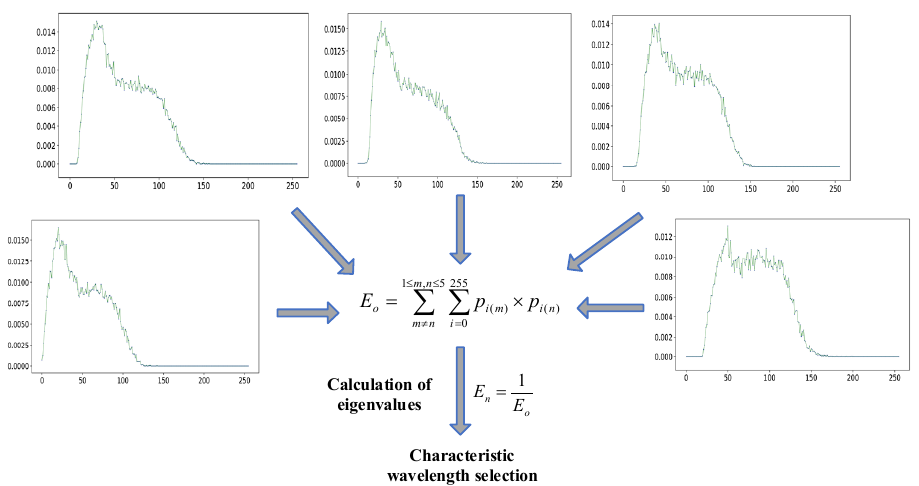
Figure 2. Schematic diagram of fine wavelength selection scheme.